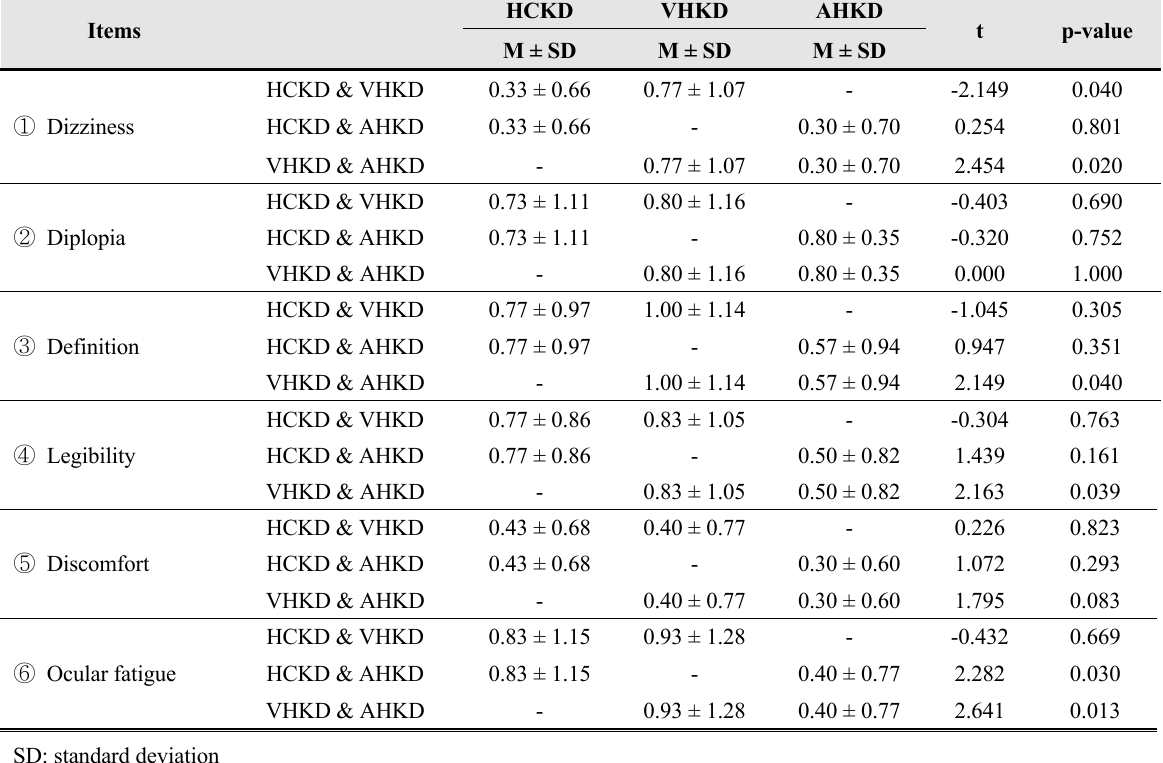
Subjective symptoms between K-D